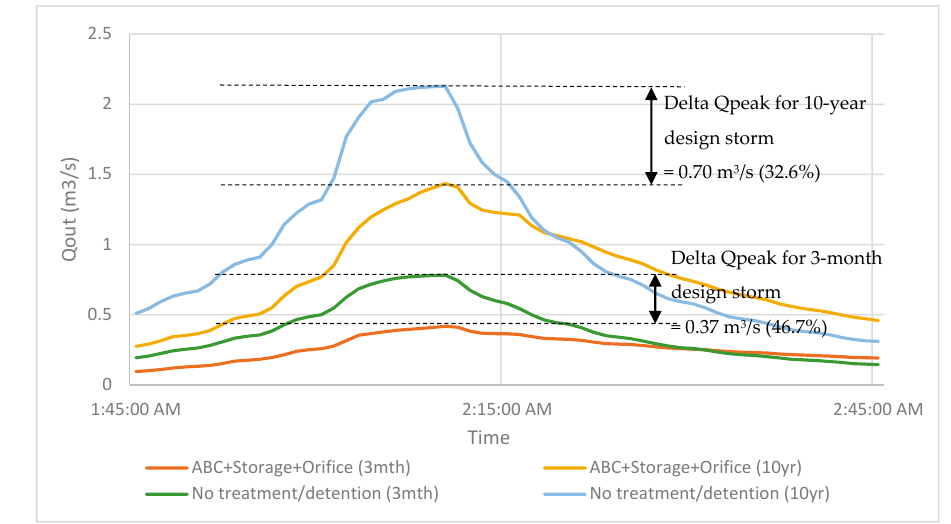
Figure 12. Peak flow difference between the best and worst performing scenario for the 3-month and 10-year design storms.